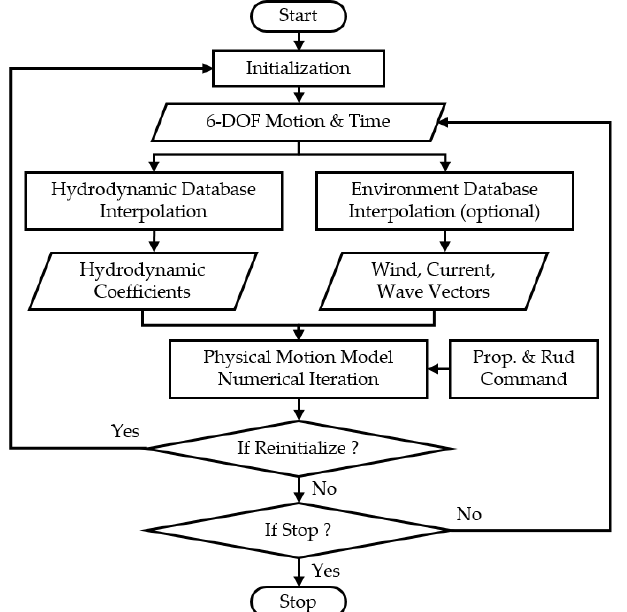
Figure 2. Flowchart of ship motion